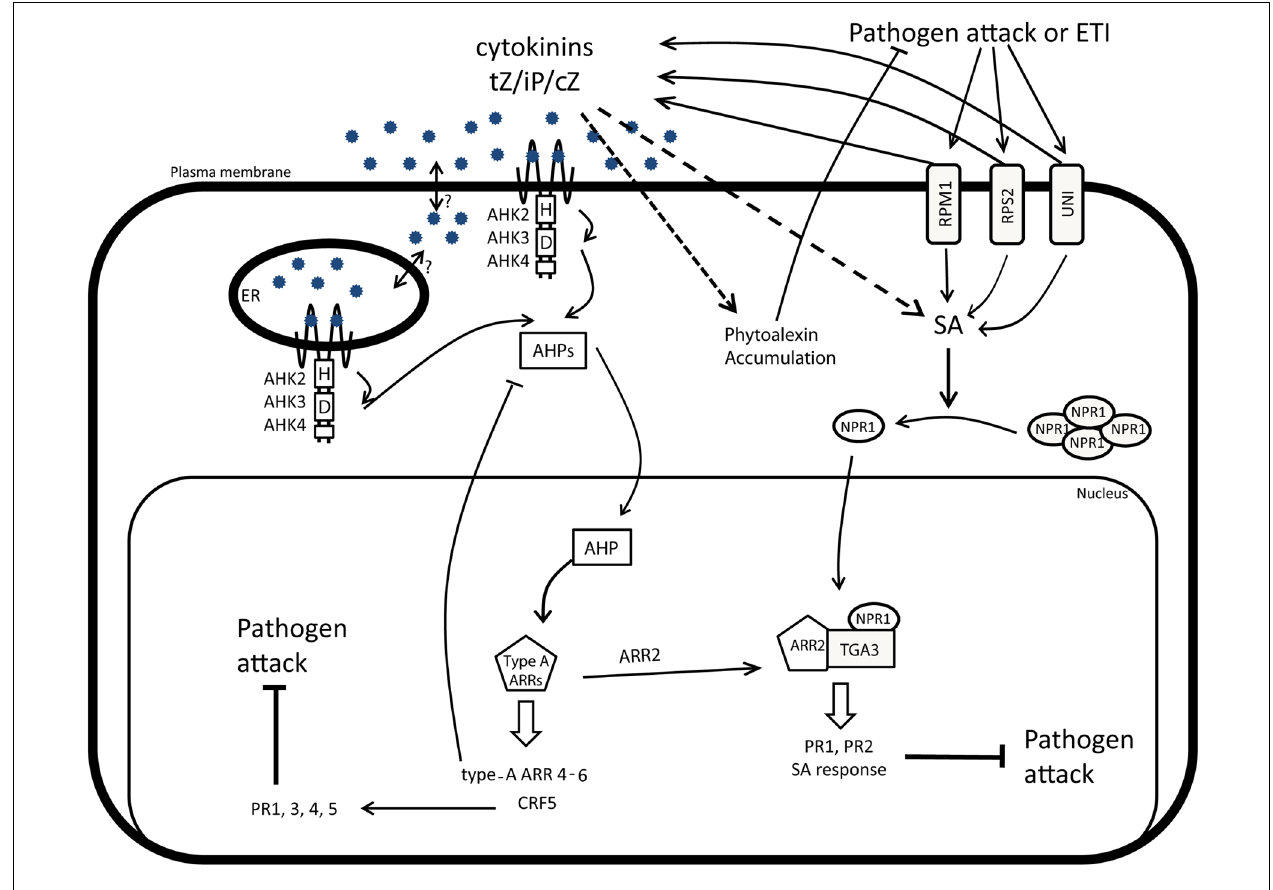
activity is further regulated through interaction with the type-B ARR2 response regulator, a component of the CK signaling pathway.The TGA3-NPR1-ARR2 complex is required to induce the SA-mediated resistance and to trigger the expression of PR1 and PR2 . High CK levels, induced after pathogen attacks, can activate the CRF5- mediated branch of the CK signaling pathway and contribute to the regulation of the PR1 , PR3 , PR4 , and PR5